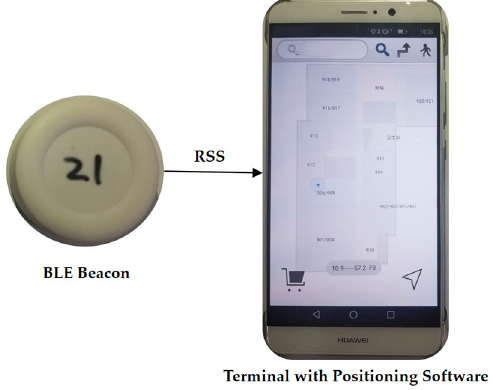
Figure 8. The BLE beacons and terminal used in this work.